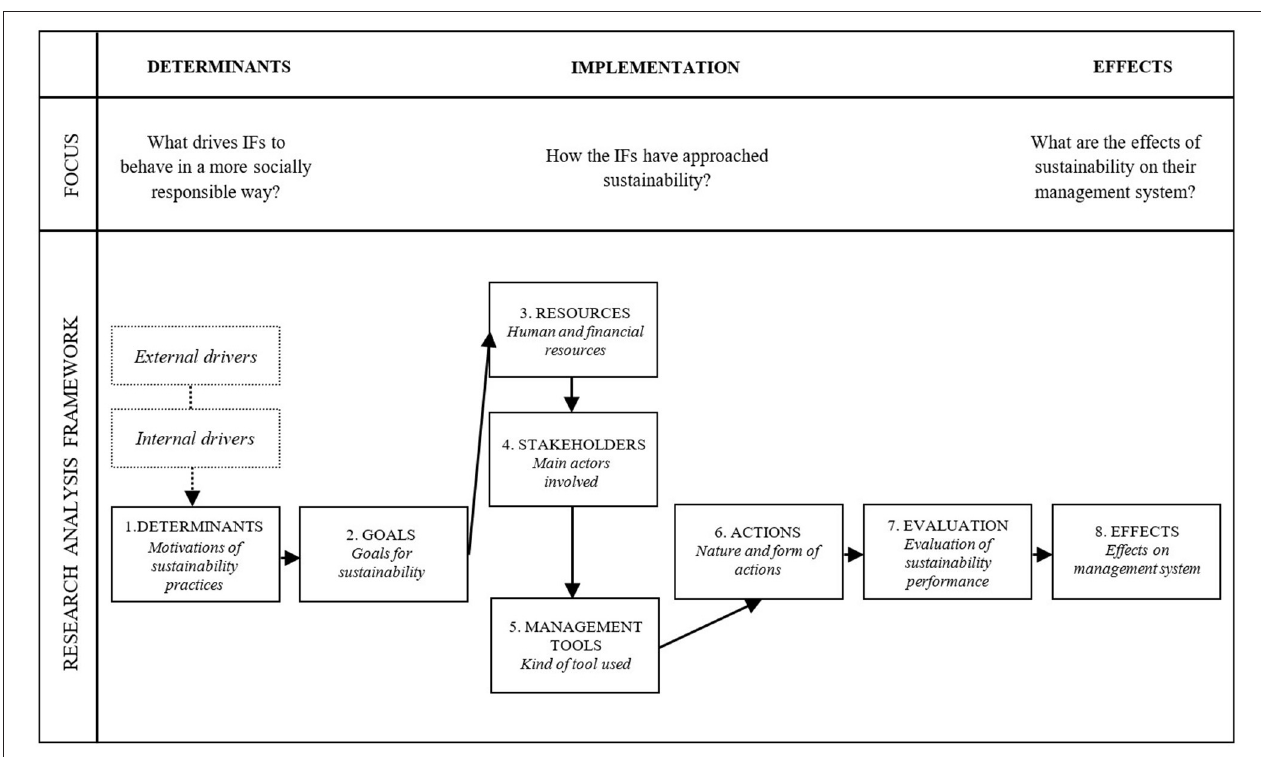
FIGURE 1 | Analysis framework for the study (adapted from François and Bayle, 2015, p.